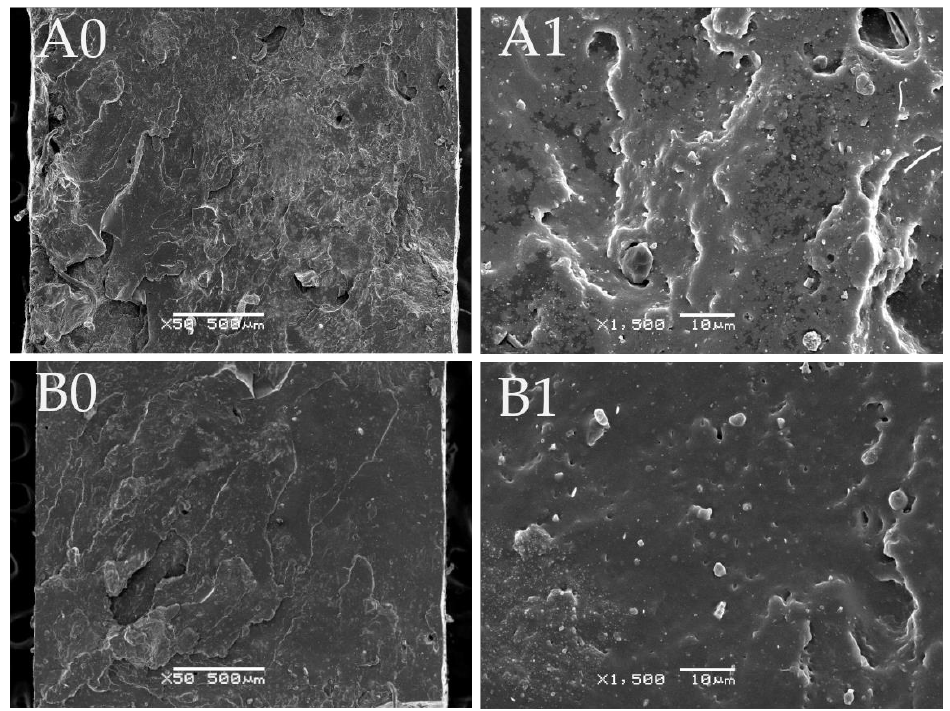
Figure 7. SEM images of: A0, A1 — GTR + 10 wt % SBS L7417-S (magnification × 50; magnification × 1500); B0,B1 — GTR + 10 wt % SBS L7417-DCP (magnification × 50; magnification × 1500) .